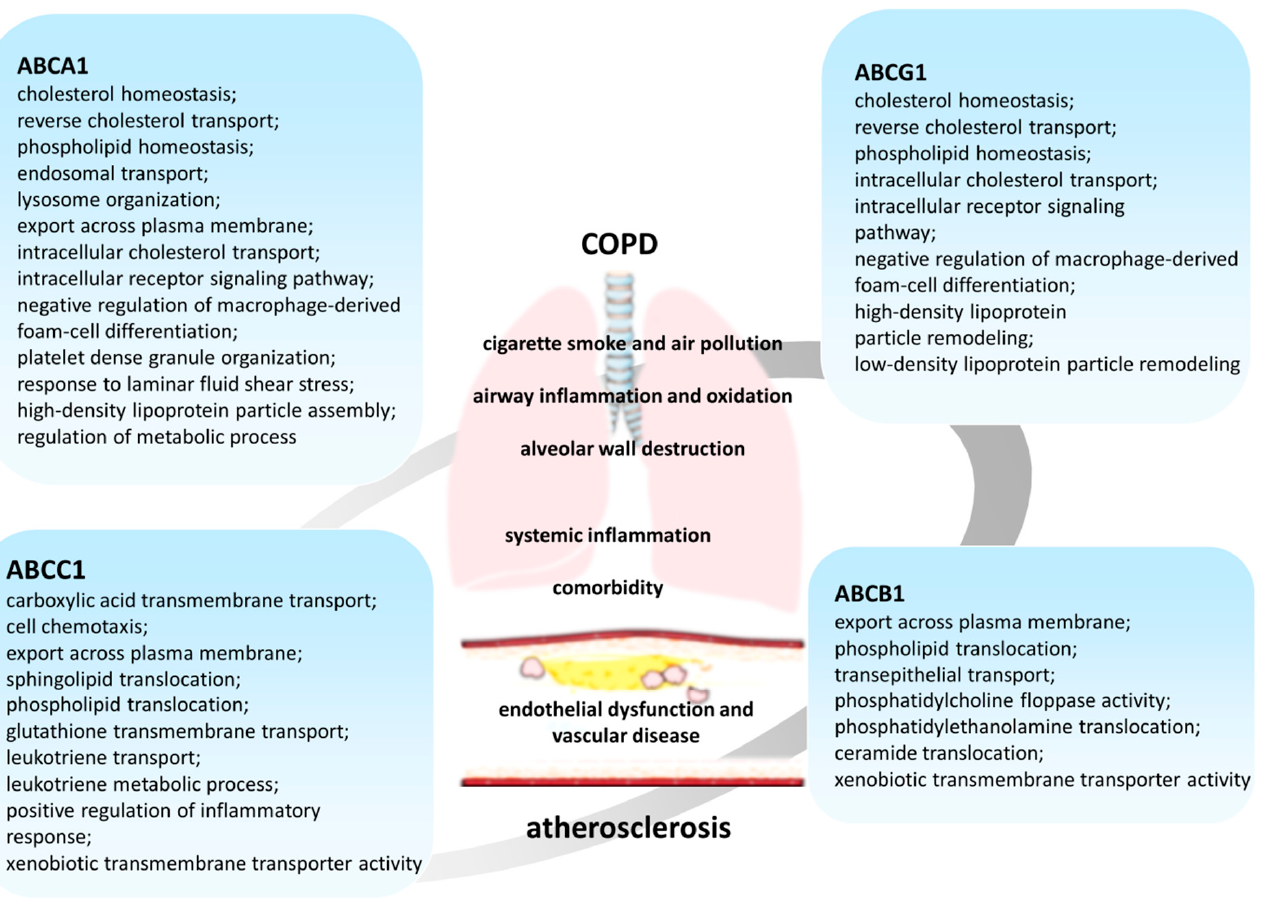
Figure 2. Biological processes and molecular functions of ABC transporters in the pathogenesis of COPD and athero- sclerosis.